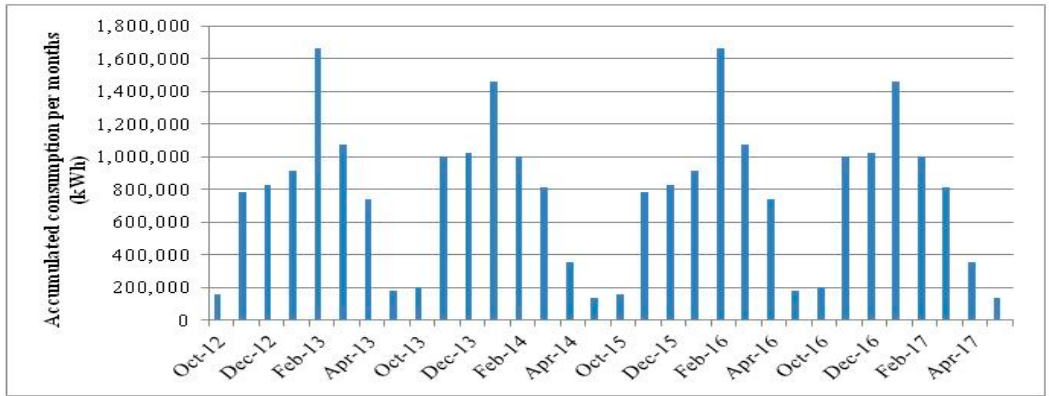
Figure 5. Total heat consumption of Miguel Delibes campus buildings during the reference and study period.